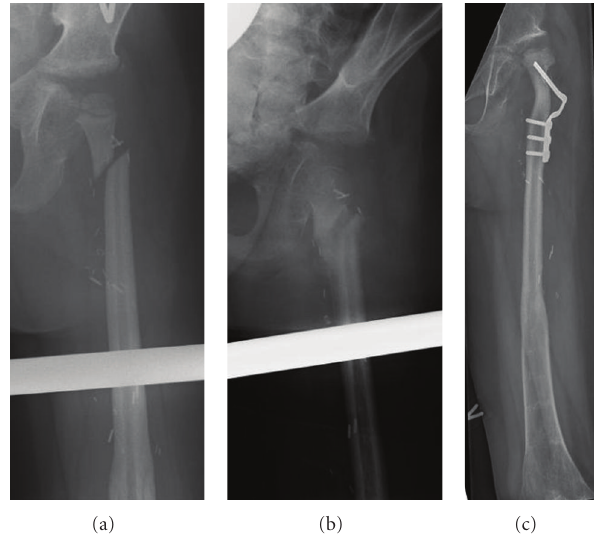
Figure 4: Resection of the proximal part of the femur because of Ewing’s sarcoma and reconstruction with a vascularized fibula graft including the proximal epiphysis (patient 2). X-rays taken 13.5 months postoperatively after the patient had sustained a fracture from falling while doing gymnastics at school (a), and with follow-up 2 months after the fracture (b). X-ray 3 years after insertion of the fibula graft; a proximal osteotomy has been performed because the fracture healed in an unfavourable position leading to an unstable hip joint